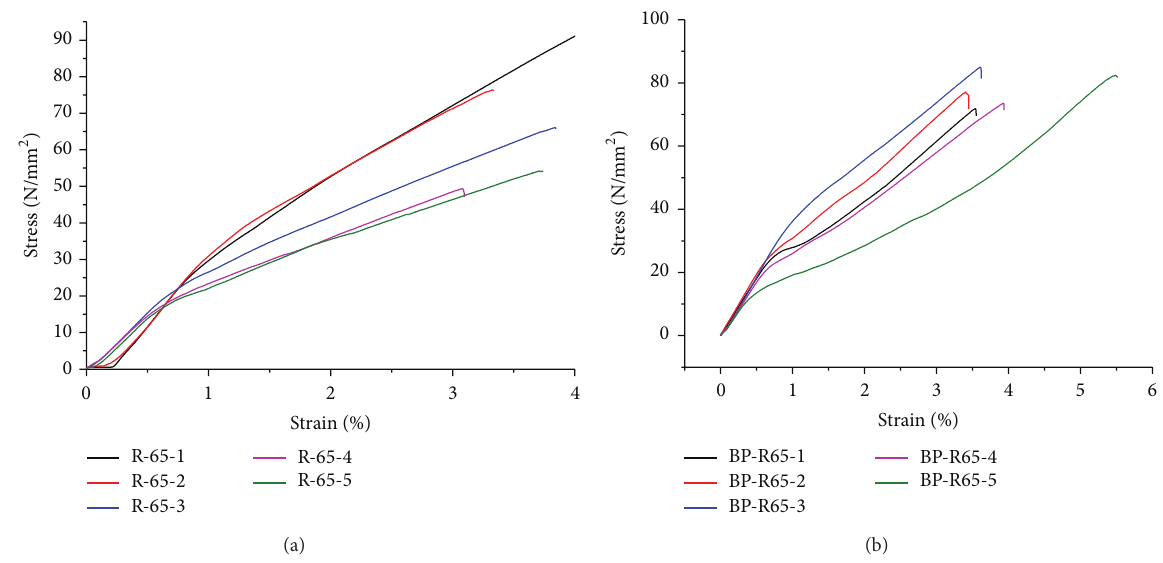
Figure 5: Tensile strength values of composite materials filled with CaCO 3 (a) and basalt particles (b).